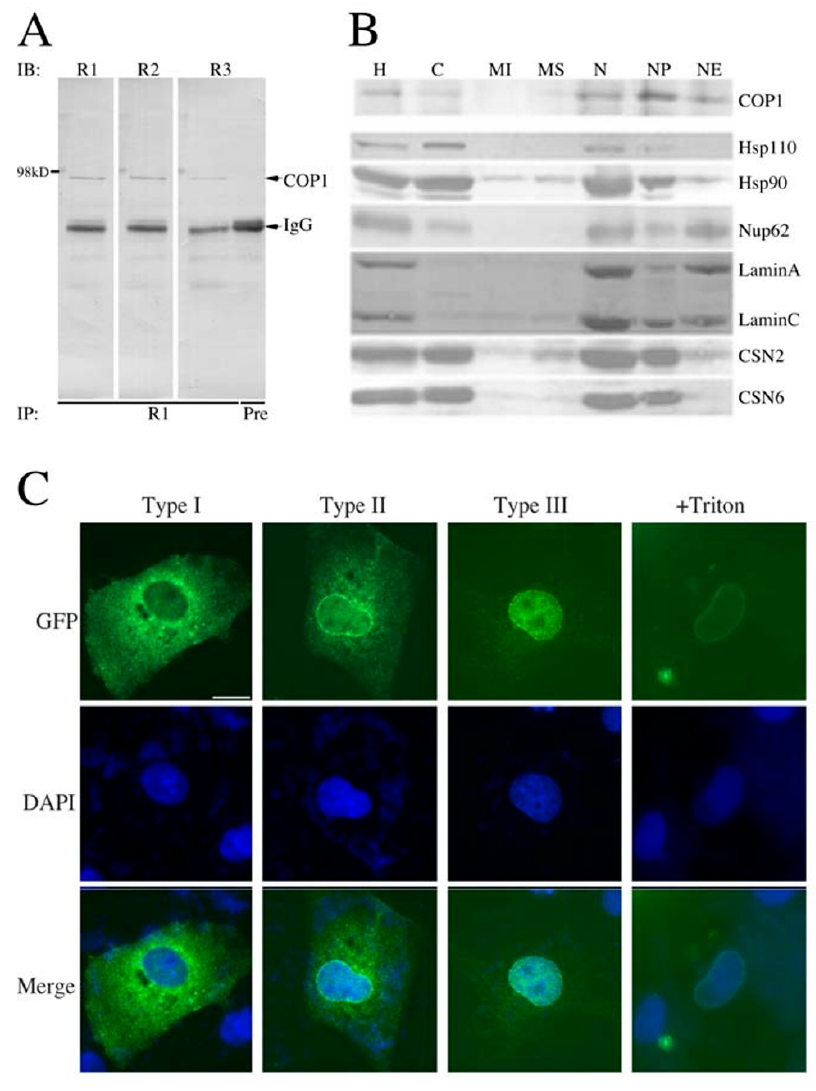
Figure 3 Subcellular localization of the mammalian COP1 (A) Detection of endogenous HsCOP1 protein by immunoprecipita- tion and immunoblot. Whole cell lysates of HeLa cells were immunoprecipitated with purified anti-COP1 antibodies from rab- bit 1 (R1) or preimmune serum (Pre) as indicated, separated by SDS-PAGE, and then immunoblotted with anti-COP1 antibodies from rabbit 1, 2, and 3. The arrowheads mark the endogenous HsCOP1 protein and IgG. R1, blot probed with puri- fied COP1 antibodies from rabbit 1; R2, blot probed purified COP1 antibodies from rabbit 2; R3, blot probed with purified COP1 antibodies from rabbit 3; Pre, preimmune serum was used for IP.(B) Localization study of endogenous HsCOP1 by sub- cellular fractionation. Subcellular fractions of HeLa cells were either immunoprecipitated with anti-COP1 antibodies first, or were directly separated (for all other control proteins) by SDS-PAGE and immunoblotted with antibodies against COP1, Hsp110, Hsp90, Lamin A/C, nucleoporins (mAb414), CSN2 and CSN6 from the top to the bottom panels as indicated. H, homogenate; C, cytosol; MI, mitochondria; MS, microsomes; N, nuclei; NP, nucleoplasm; NE, nuclear envelopes. (C) GFP fluo- rescence analysis of the subcellular localization of GFP-tagged MmCOP1 protein. N-terminal GFP-tagged MmCOP1 expression construct was transfected into COS7 cells. The cells were fixed with 4% paraformaldehyde 24 hours after transfection. Type I to III are representative of three distinct types of localization patterns, while +Triton indicates cell treated with 1% Triton in PBS for 10 min on ice and then washed three times with PBS before fixation. The subcellular localization of GFP-COP1 was observed under Zeiss Axiophot fluorescence microscope (top). The nuclei were stained by 1% DAPI in anti-fade reagent (mid- dle). The merged pictures of the DAPI and GFP fluorescence images are shown at bottom. The same magnification was used for all the images and the scale bar for 10 micrometer was indicated within the top left